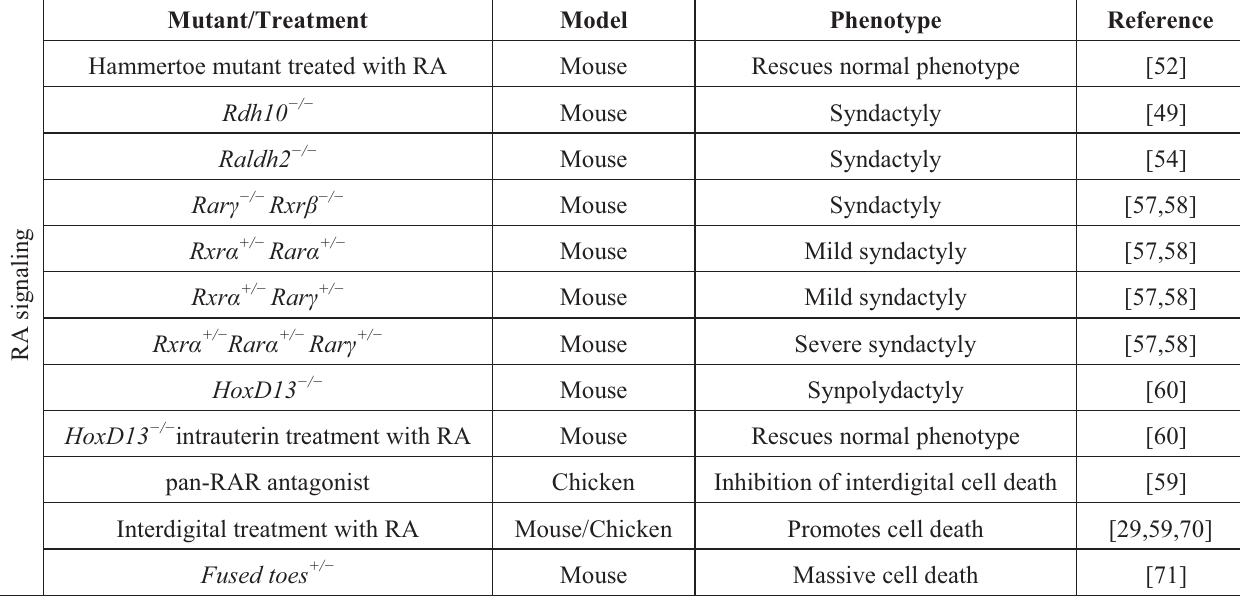
Table 3. Phenotypes observed in mutant mice for genes related to retinoic acid (RA) signaling or in embryonic chick limbs treated with RA or pan-RAR antagonist (see text for